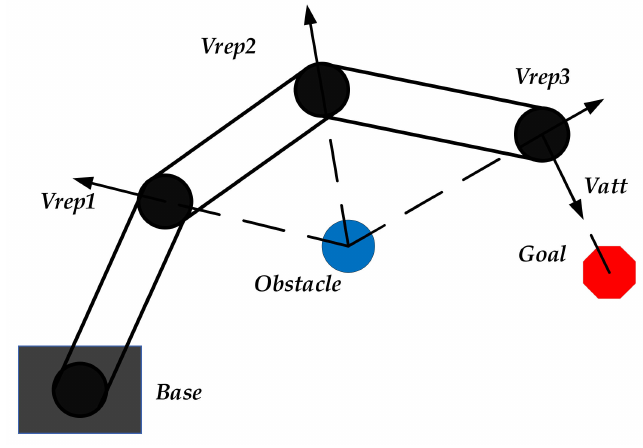
Figure 4. The speed of the robot in the artificial potential